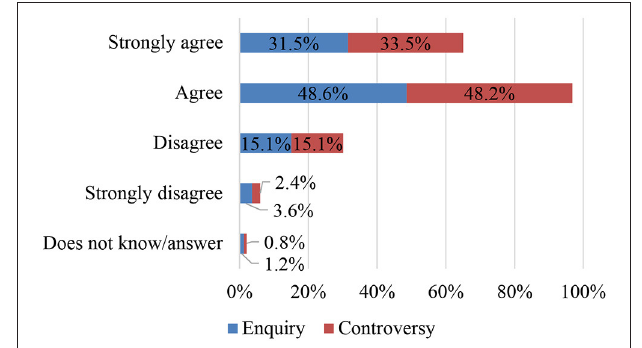
FIGURE 8 | Item 23. Teaching materials in line with the teaching methodology.